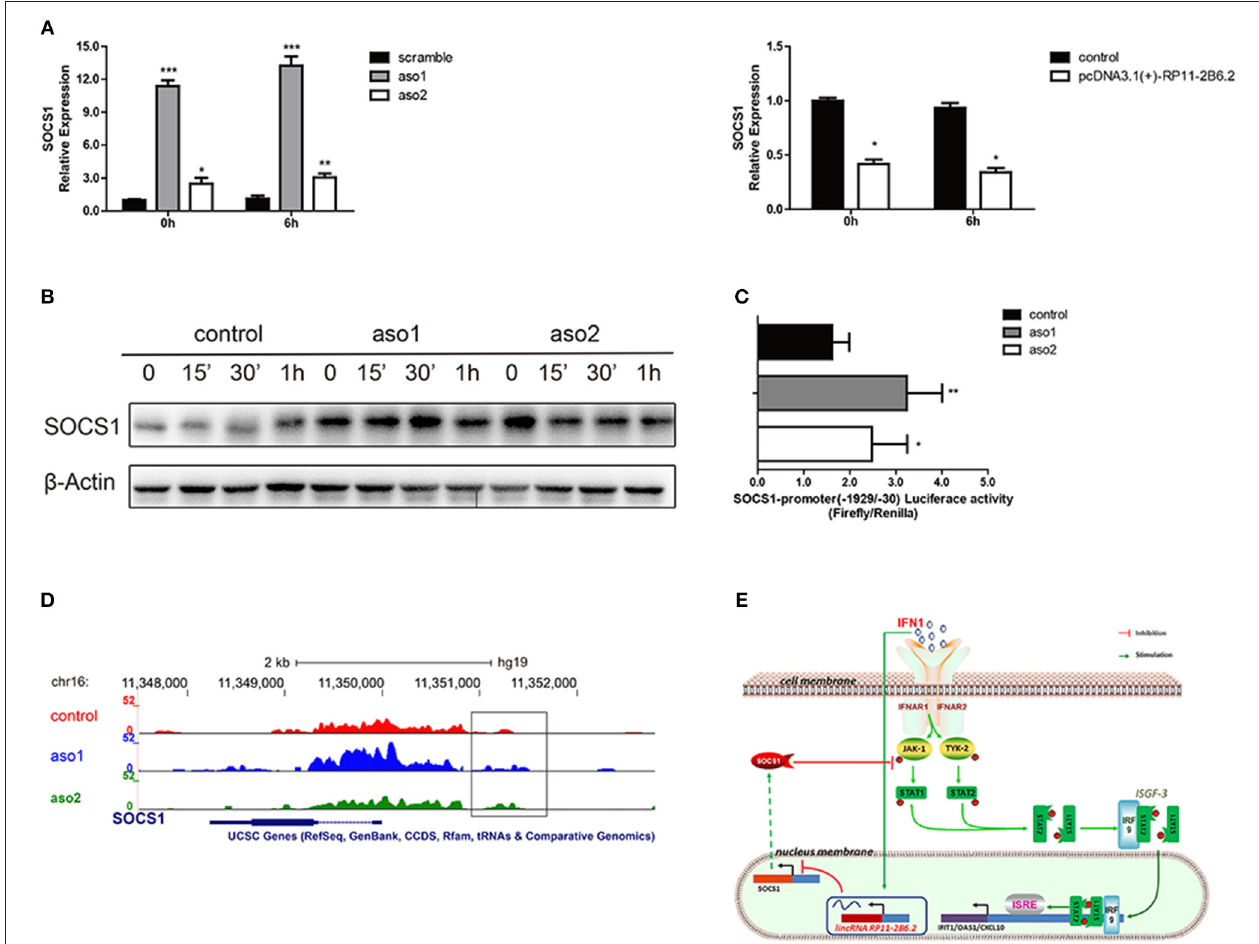
FIGURE 4 | LncRNA RP11-2B6.2 Suppresses the Transcription of Negative Regulator SOCS1 in IFN-I Pathway. (A) The mRNA level of SOCS1 in HeLa cells with lncRNA RP11-2B6.2 ASOs or scramble, lncRNA RP11-2B6.2 overexpression or empty pcDNA 3.1( + )-5 ′ -HA vector, were determined by qPCR. (B) The protein level of SOCS1 in HeLa cells with lncRNA RP11-2B6.2 ASOs or scramble, were determined by western blotting. (C) The promoter activity of SOCS1 in HeLa cells with lncRNA RP11-2B6.2 ASOs or scramble, were determined by dual-luciferase reporter assay. (D) The chromatin accessibility of SOCS1 in HeLa cells with lncRNA RP11-2B6.2 ASOs or scramble, were determined by normalized ATAC sequencing analysis. (E) Schematic diagram of the mechanism by which lncRNA RP11-2B6.2 positively regulates the IFN-activated classical JAK-STAT signaling pathway. IFN-I triggered an unknown transcriptional factor to induce lncRNA RP11-2B6.2 expression. LncRNA RP11-2B6.2 subsequently enhanced the IFN-I-induced phosphorylation of TYK2, JAK1, and STAT1 through attenuating of SOCS1 at the transcriptional level, and eventually leading to the increased expression of IFN-I stimulated inflammatory genes. * P < 0.05, ** P < 0.01, *** P <